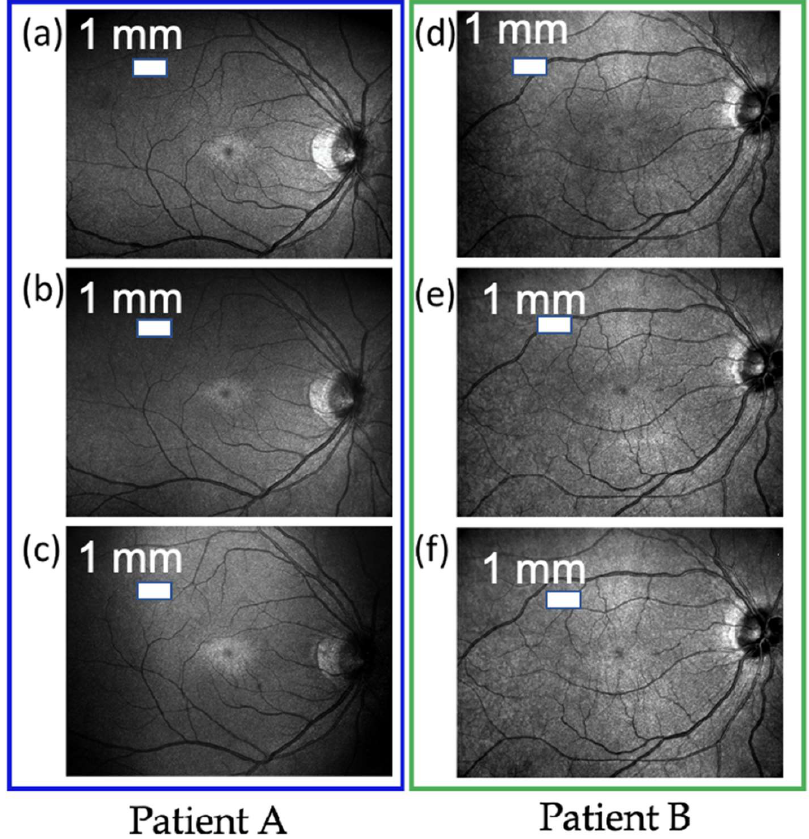
Figure 5. Comparative analysis of clinical treatment effects. Results showed improvement of eye floaters symptoms through fading of macular shadows and floating objects compared to baseline disease ( a , d ), after 2 months of treatment ( b , e ), and after 4 months of treatment ( c , f ) of 2 patients A and B.